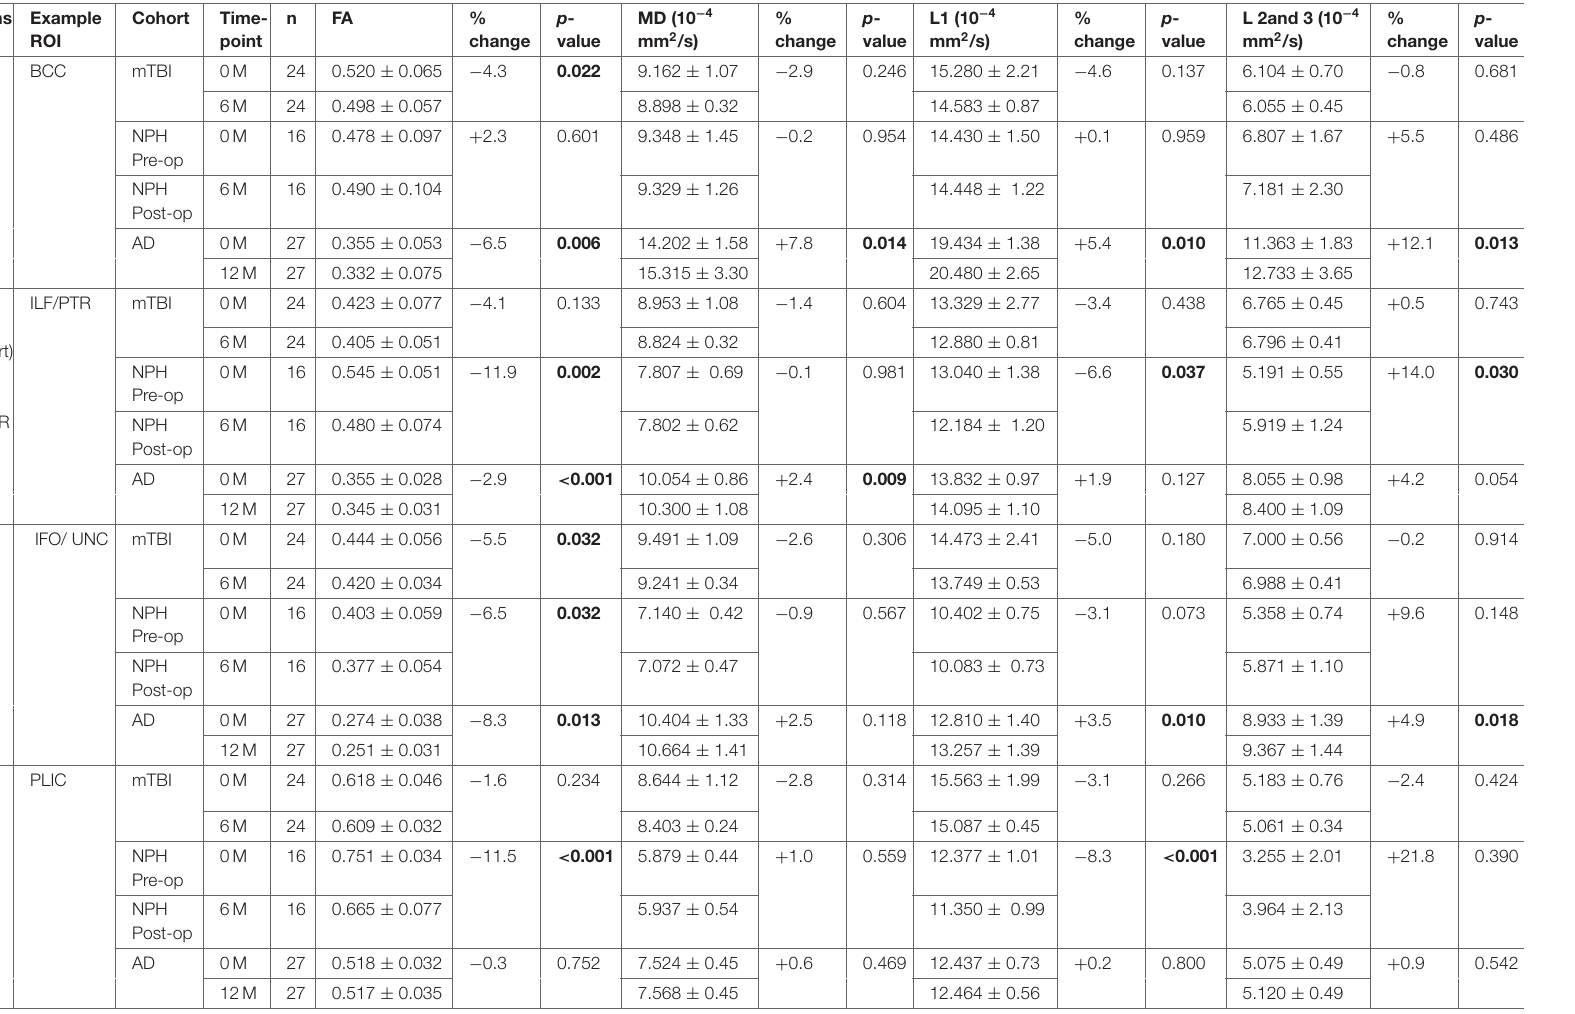
TABLE 3 | Comparison of example DTI region of interest values within clinical cohorts at baseline and at 6 or 12-month